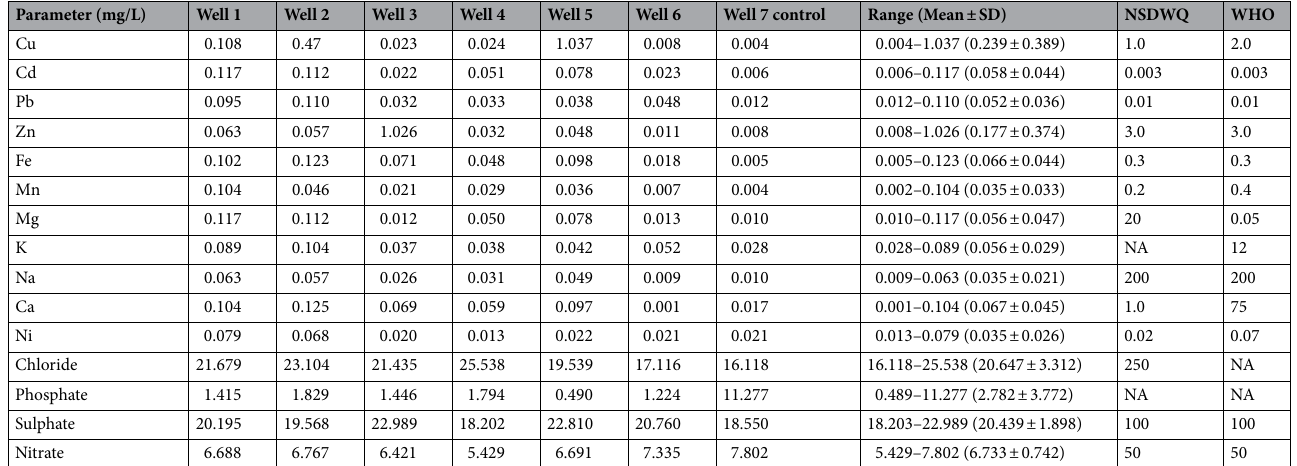
Table 3. Hydro-chemical analysis of the well water samples. SD = Standard Deviation; NA = Not Available; NSDWQ = Nigerian Standard for Drinking Water Quality. WHO = World Health Organization.